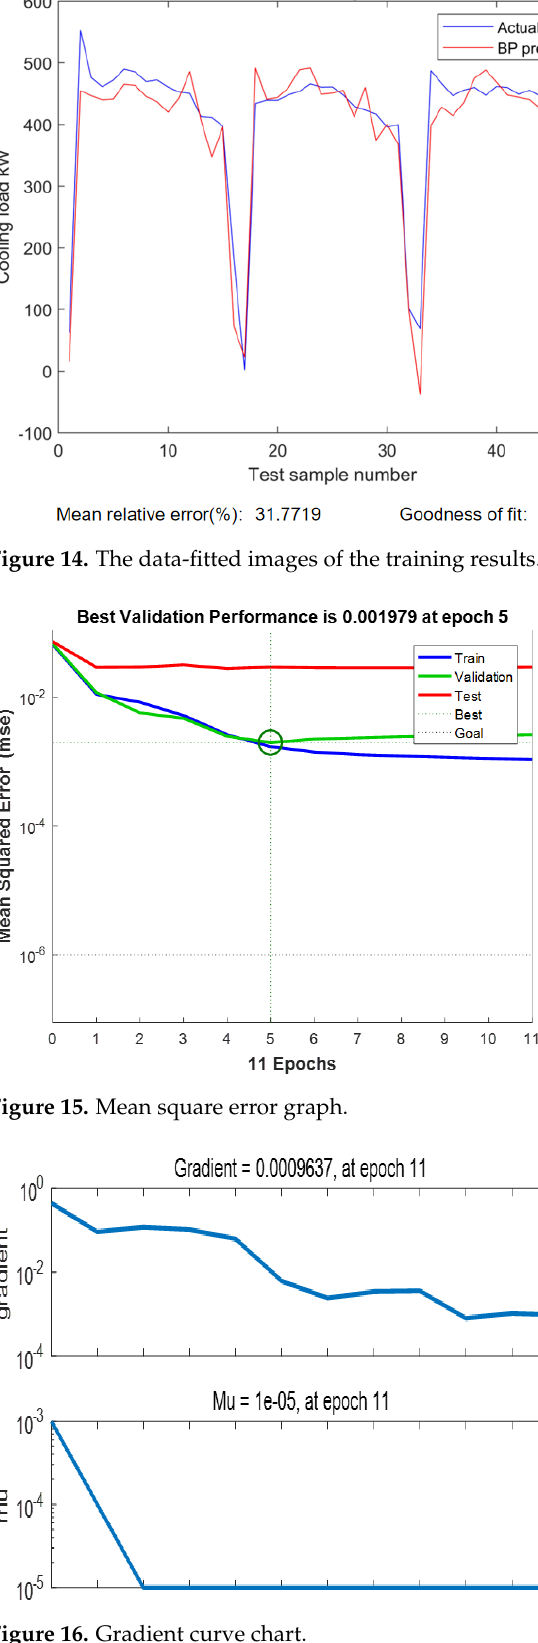
Figure 13. Neural network structure diagram.